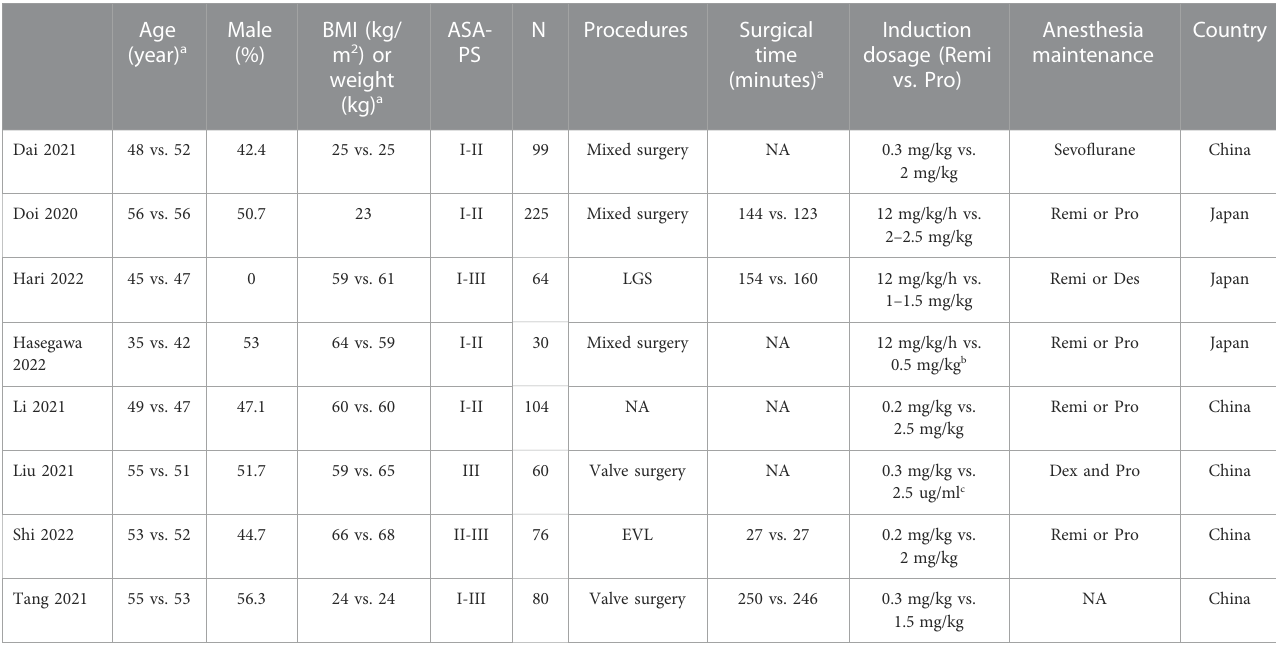
TABLE 1 Characteristics of studies (n =